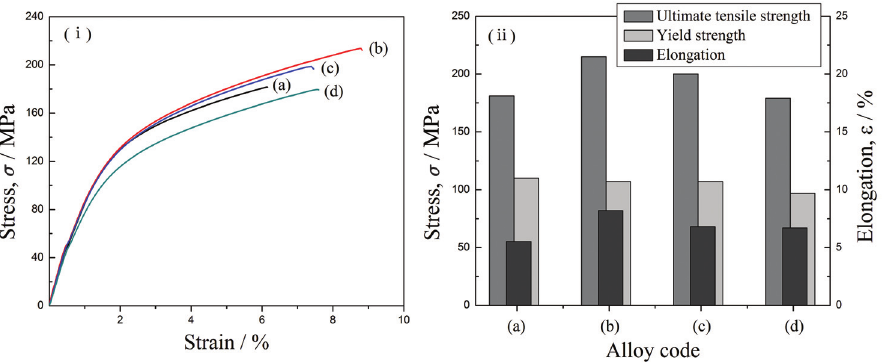
Figure 6: The typical stress – strain curves ( ⅰ ) and tensile properties ( ⅱ ) of the as-cast AZ80 – 2Sn alloys with different Y additions tested at RT.